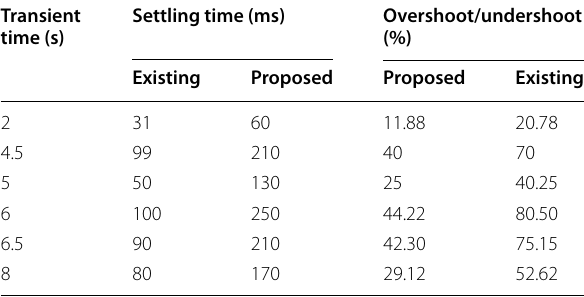
Table 7 Quantitative analysis for BESS power Transient Settling time (ms) time (s)